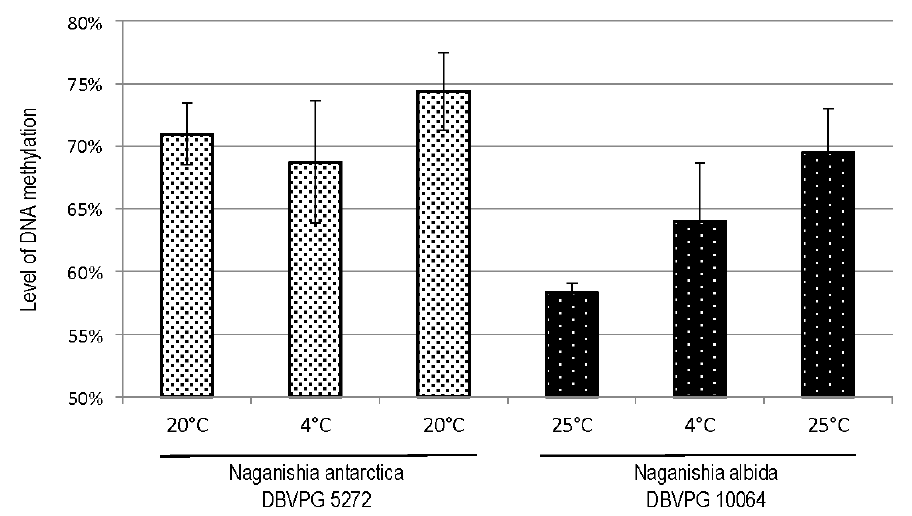
Figure 4. Relative level of DNA methylation as inferred by MSAP in N. antarctica DBVPG 5271 and N. albida DBVPG 10064 during the seeding and incubation cycles.